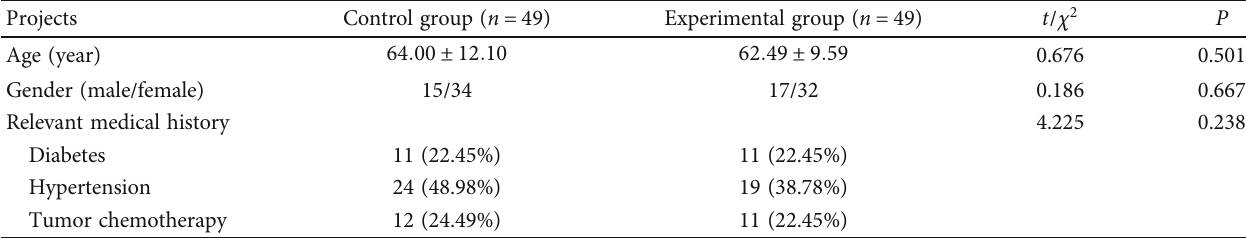
Table 2: General data of the two groups of patients with di ffi cult veins.